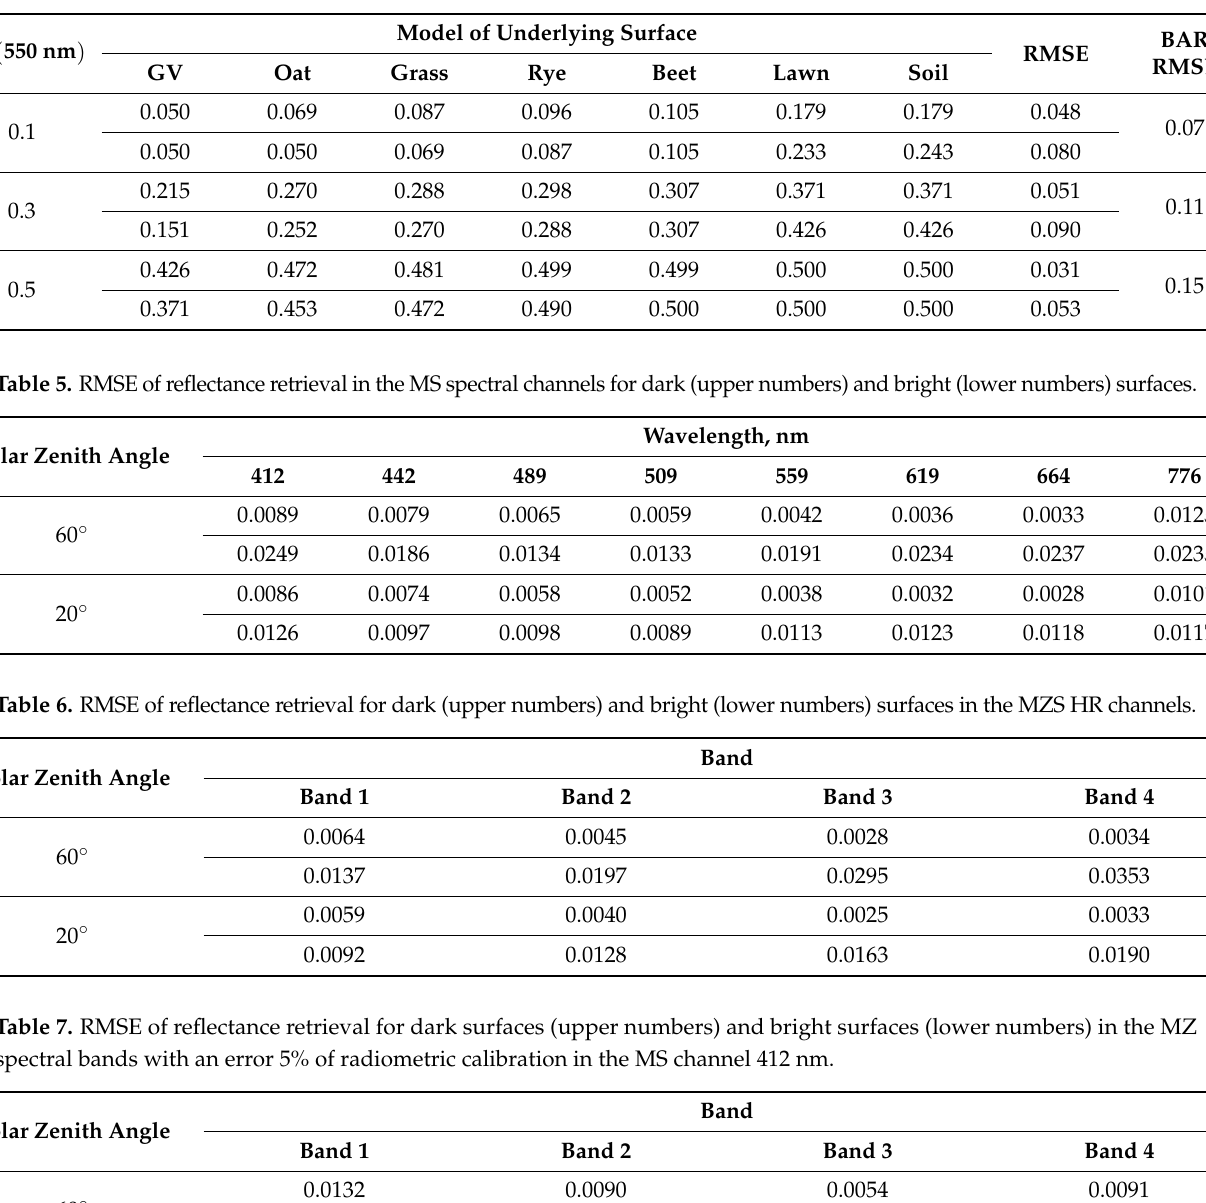
Table 4. Values of AOT at λ = 550 nm, retrieved for models of various underlying surfaces under the assumption r surf ( 412 nm ) = 0.028, and RMSE, with three values of the real τ aer ( 550 nm ) and solar zenith angles 60 ◦ (upper numbers) and 20 ◦ (lower numbers).